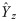
(a-b) Experimental data for animal 2RC003. (c) Difference between experimental Y^z and simulated Yz(Le) as a function of Le. The values of his are set to be equal to H+y^i, and the model was simulated 200 times at each value of Le. Other parameters are taken from Tables 1 and 2. The LSE Le*=25.0 and (Ass+)*=6.7. (d) Comparison of the optimal Yz to the experimental Y^z.